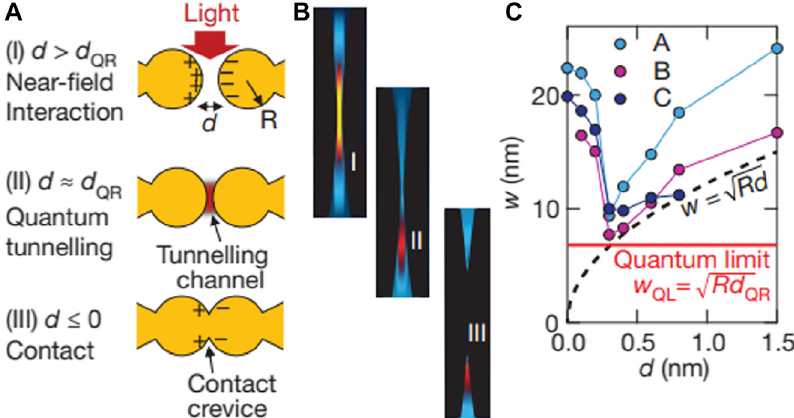
Figure 5: Nonlocal effects in 1 – 10 nm-wide gaps operating at infrared frequencies. (A) Electricfield distributionat vicinity of a 1nm-widegapinlocal andnonlocalpictures.Here, b is fi ttingparameterforthe nonlocaleffect.(B) Shift in resonance wavelength as a function of gap size, depending on local and nonlocal pictures. (C) Calculated transmittance spectra for different gap widths in local and nonlocal pictures. Note that for gap size smaller than 7 nm transmittance is larger for the nonlocal picture compared to the local counterpart, while for the 10 nm-wide gap the trend is opposite. Reproduced with permission from [60].